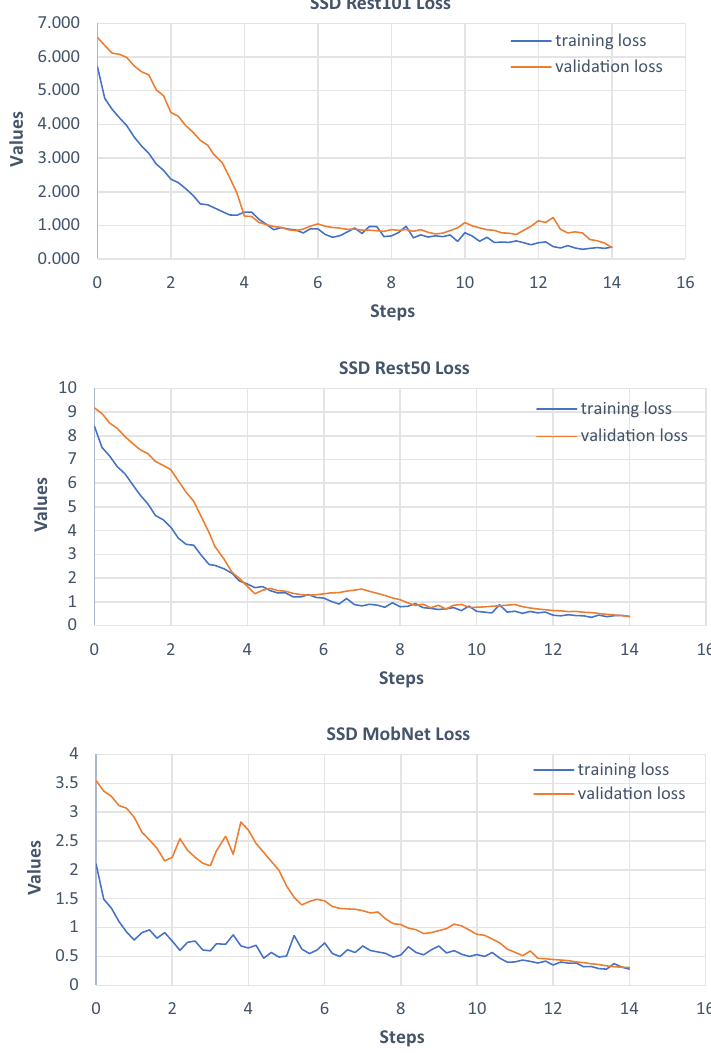
Fig. 12 Epoch vs. loss graphs over time